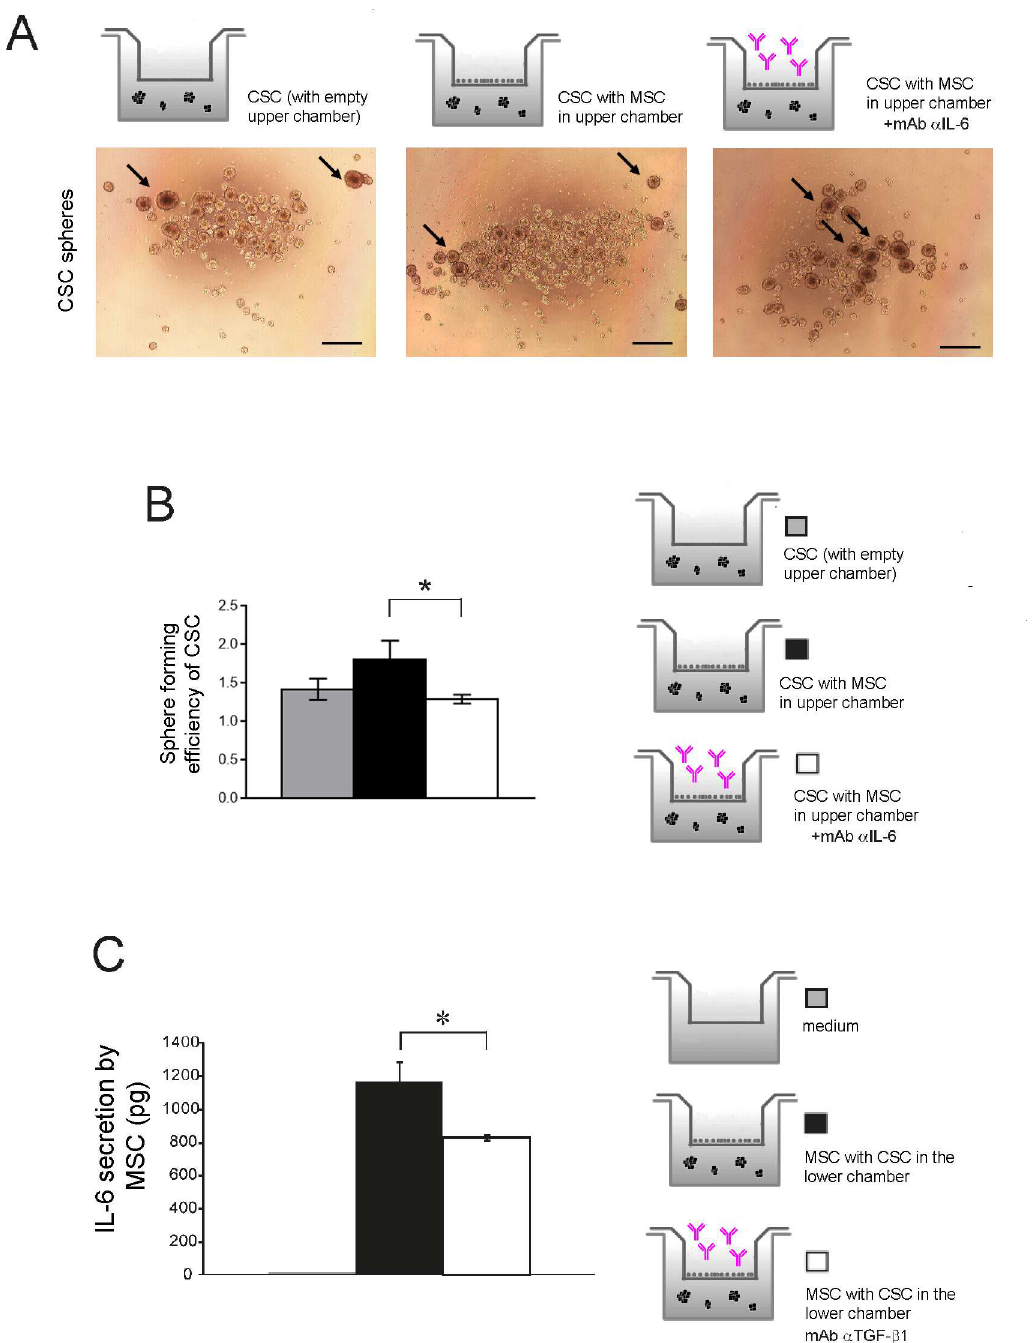
Fig 7. TGF β 1-dependent IL-6 secretion is responsible for increased CSC sphere formation. (A) HOS-CSC were let to grow for 6 days in the presenceof MSC; the latter cells were added every 24 hours with 100 μ g/mL of Tocilizumab.Sphereswere then photographed, counted, and quantified(scale bar, 500 μ m). Representative figures and schematic representation of the performed assay; (B) Treatment with Tocilizumab significantly decreased the number of HOS-CSC spheres showed in panelA ( * p < 0.05); (C) IL-6 secretionby MSC is TGF β 1 dependent. MSC were treated with 1 μ g/mL mAb α TGF β 1 2 hours prior CSC seeding, and re-addedevery 24 hours for the three days of co-culture. Supernatants from the MSC upper compartmentwere then collectedand analyzedfor IL-6 secretionby ELISA assay ( * p <